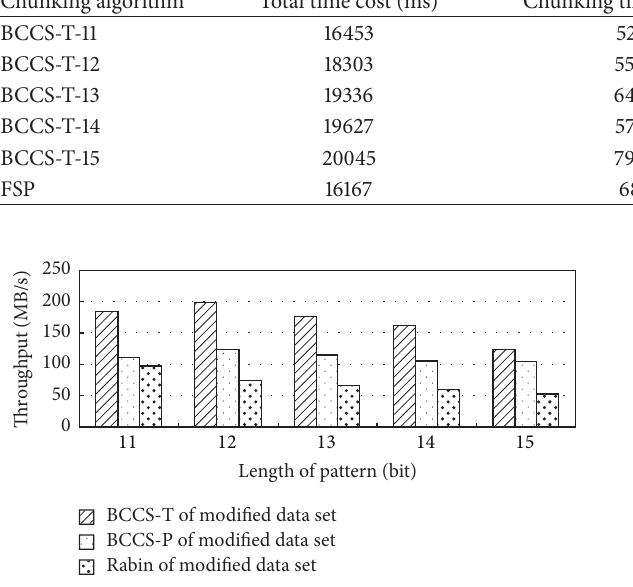
Figure 12: The comparison of chunking throughput of modified data